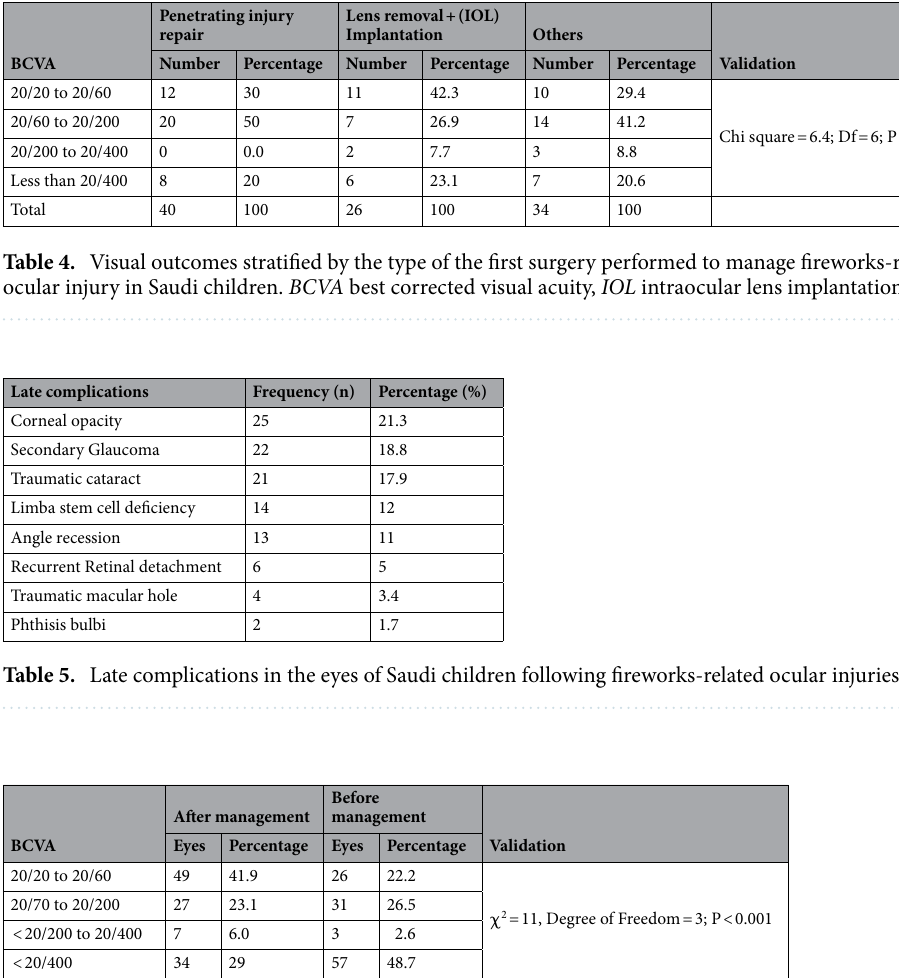
Table 4 reveals visual outcomes (BCVA) by the type of the first surgery performed to manage fireworks-related injury. The variation in visual impairment grade in the injured eyes by type of management was significant. Late complications in the eyes of Saudi children following fireworks-related injuries are displayed in Table 5. Secondary procedures included lens removal with IOL implantation, amniotic membrane transplantation, enucleation, and retinal surgeries for recurrent retinal detachment. Six patients underwent ruptured globe repair and retinal surgeries for recurrent retinal detachment and proliferative vitreoretinopathy, and four for traumatic macular holes were performed at 3–6 months of follow-up. Two patients sustained a devastating ruptured globe needing primary enucleation, and 5 needed subsequent enucleation. Twenty-one underwent lens removal with IOL implantation. Thirteen children had angle recession, and 22 who developed secondary glaucoma are on regular follow-up. After trabeculectomy failed to control intraocular pressure, the Ahmed glaucoma valve implant was used as a second-line operation to manage intraocular pressure in the same patient. On a follow-up of 1–3 years, corneal scarring was noted in 21% of cases, and keratoplasty with Amniotic membrane transplanta- tion was needed in 12 children. In thirteen cases, follow-up data were not available. Fifteen children needed no surgeries and were managed in the outpatient department. The average follow-up period after the presentation was six months and ranged from 1 to 3 years from surgical management. In the 117 eyes, the initial and BCVA, at last, follow up are shown in Table 6. The BCVA after six months was 20/20 to 20/60 in 49 (41%) eyes; 20/70 to 20/200 in 27 (23.1%); and < 20/200 to 20/400 in 7 (6%) and < 20/400 in (34;29.1%) eyes, from 51.3% eyes with < 20/200 before management, we could reduce severe visual impairment to 35.1%.